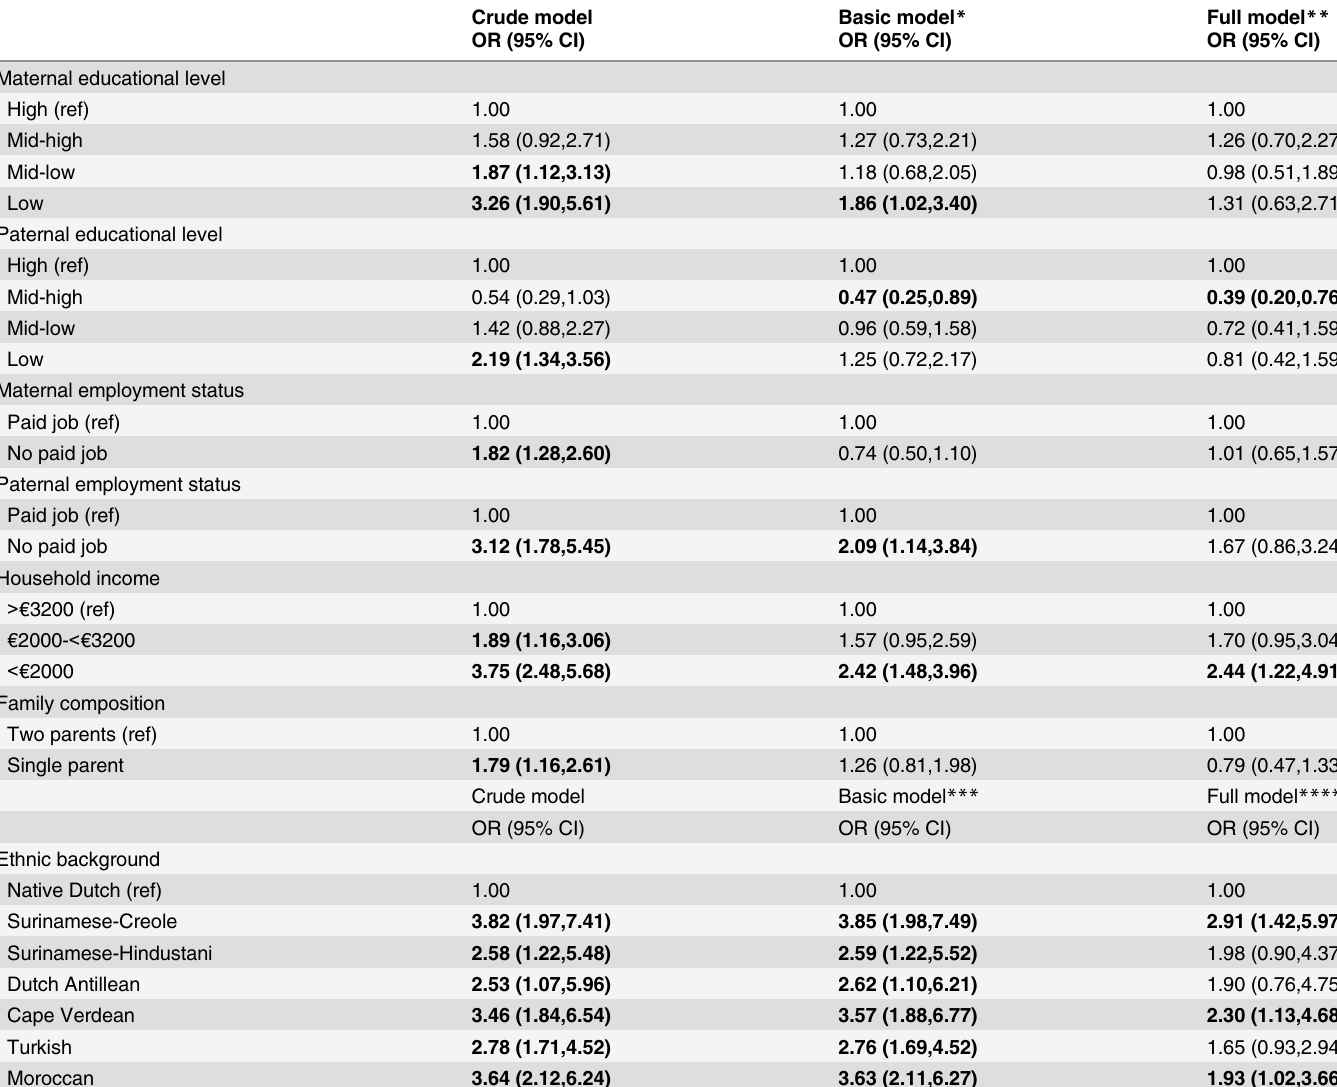
Table 5. Associations of family socioeconomic position and ethnic background with dinner skipping at age 6 years (n = 4537).